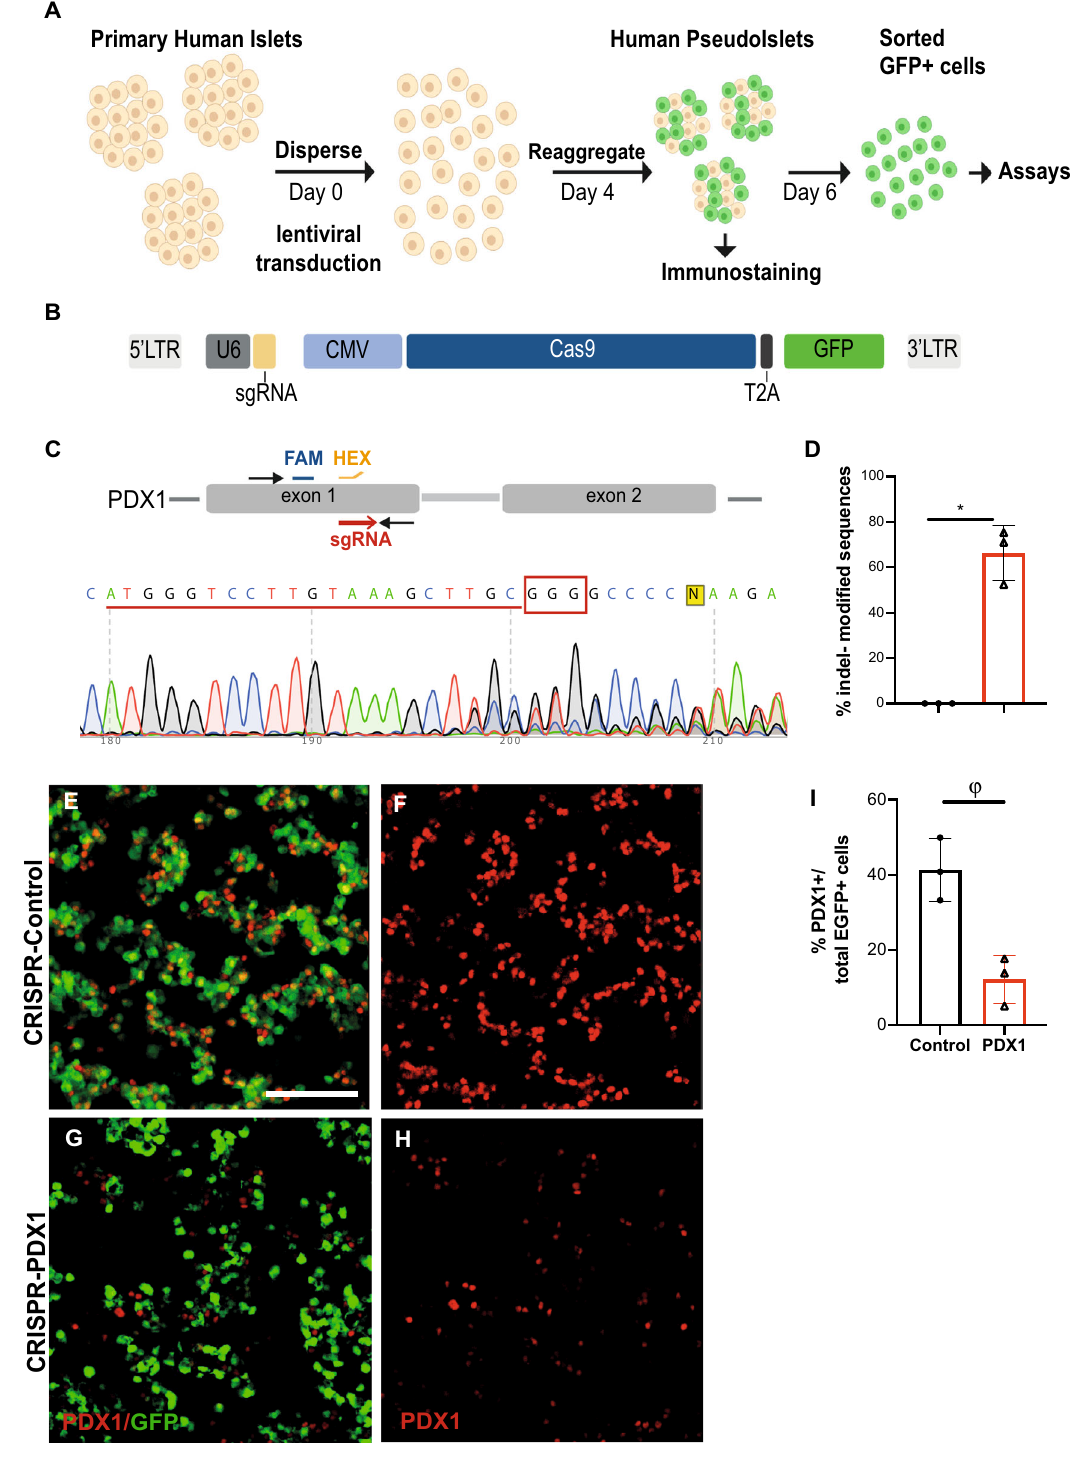
Fig. 1 CRISPR/Cas9 targeting of PDX1 protein-coding sequence in primary human islets. A Schematics of the human pseudoislet system. B Scheme of the lentiCRISPR construct used. C PDX1 sequence, showing the sgRNA sequence (underlined in red, PAM sequence recognized by Cas9 in red box). FAM (blue) and HEX (orange) probes used for ddPCR. D Percentage of indel-modi fi ed sequences detected by the TIDE algorithm ( P = 0.01). E – H Immunostaining of CRISPR-Control versus CRISPR-PDX1, showing GFP + PDX1 + cells ( n = 3 independent donor repetitions); scale bar: 50 μ m. I Quanti fi cation of GFP + PDX1 + cells for CRISPR-Control versus CRISPR-PDX1( P = 0.07; n = 3 independent donor repetitions). Data are presented as mean values ± SD. Two-tailed t tests were used to generate P -values. * P < 0.05, ϕ P < 0.1. Source data are provided as a Source Data fi